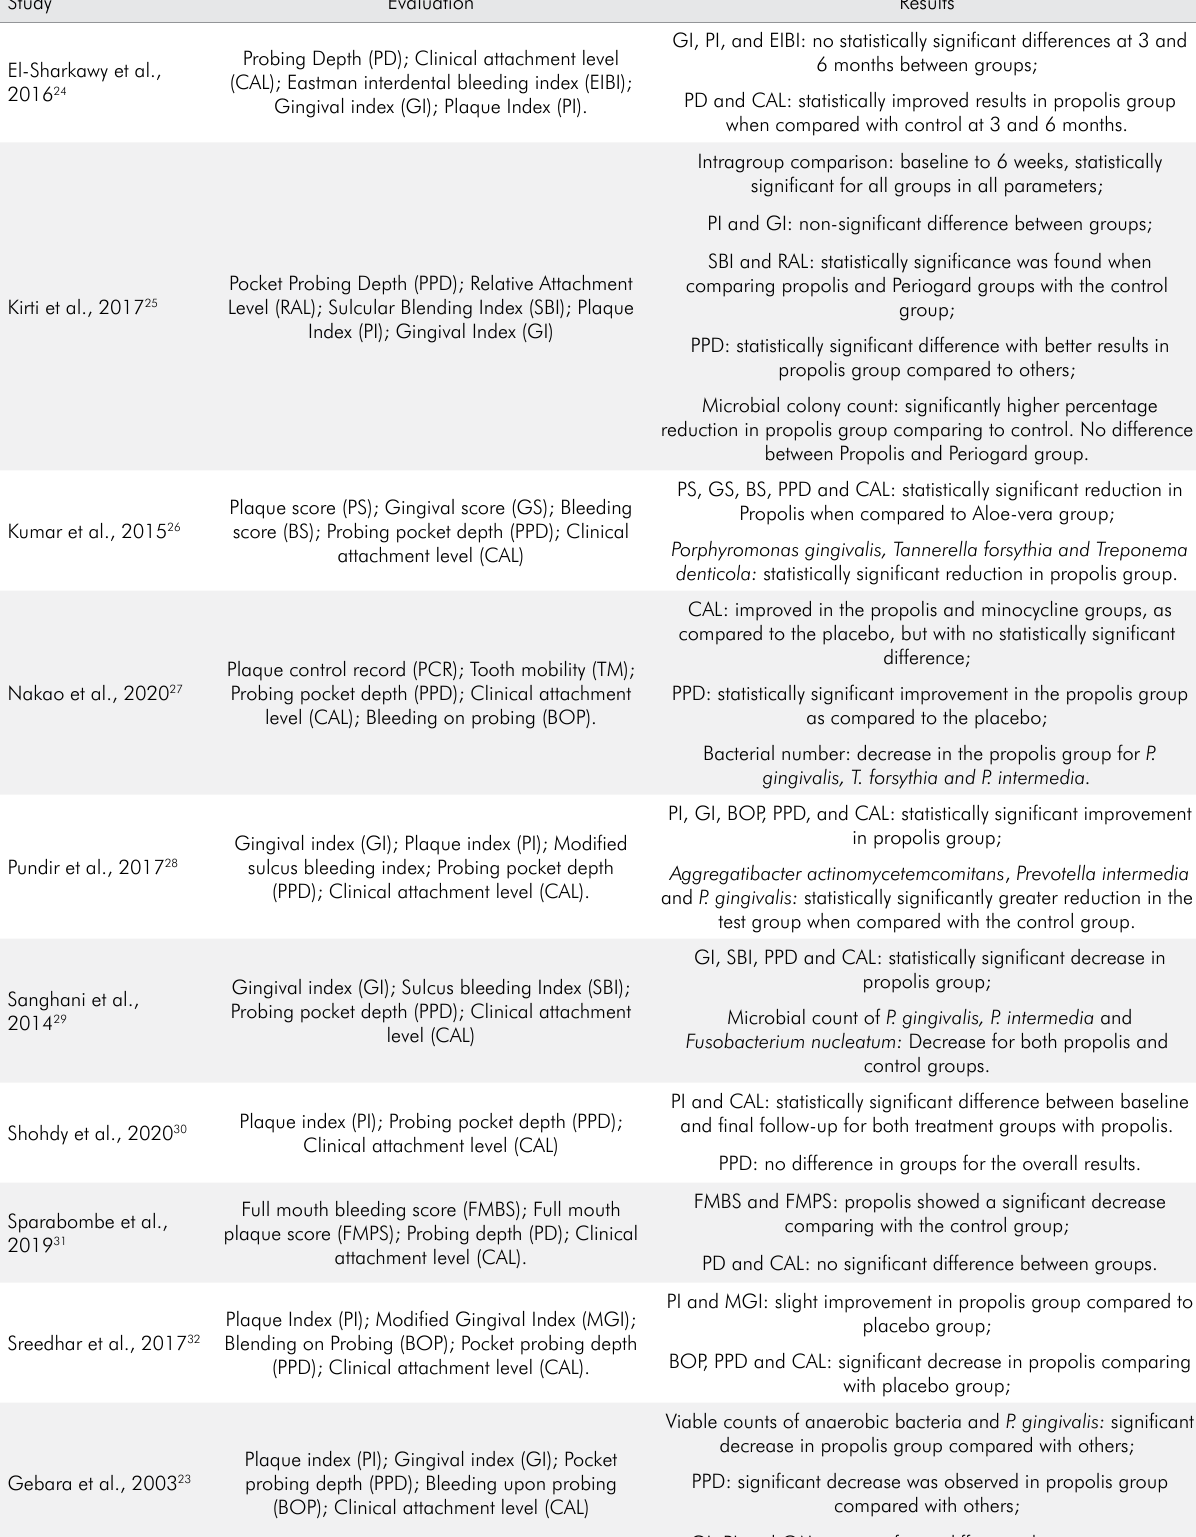
Table 3. Assessment methods and outcomes of intervention with propolis in patients with periodontal